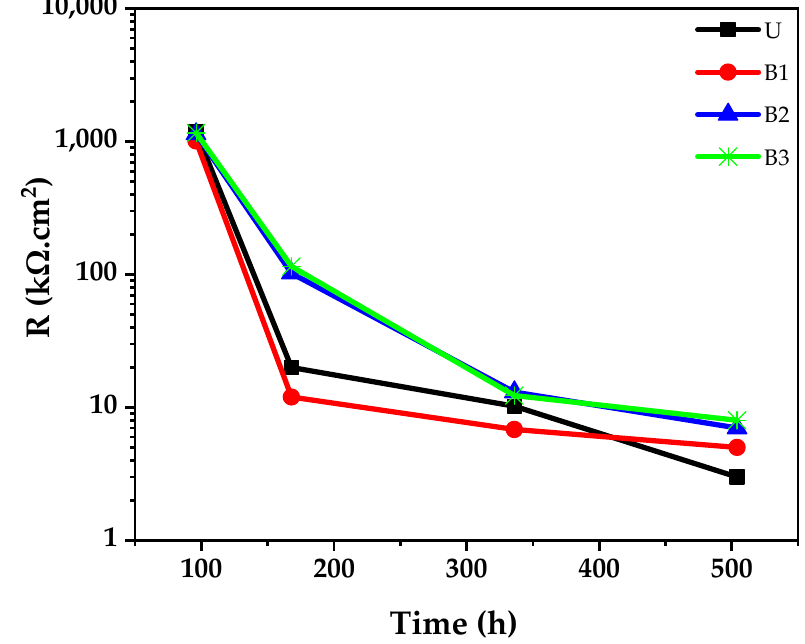
Figure 12. The variation of R in versus immersion time for the plasma electrolytic oxidation (PEO) coatings.